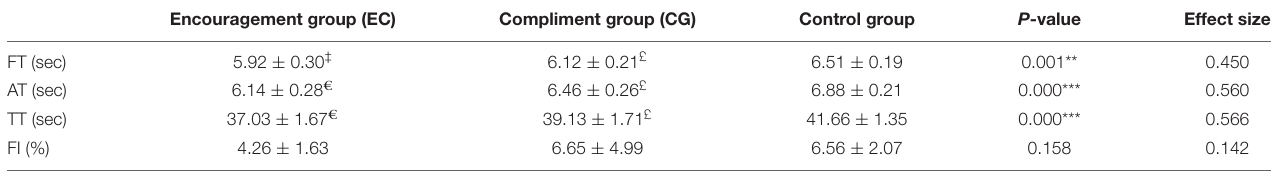
TABLE 1 | Mean values of performance indices for the repeated change of direction test.